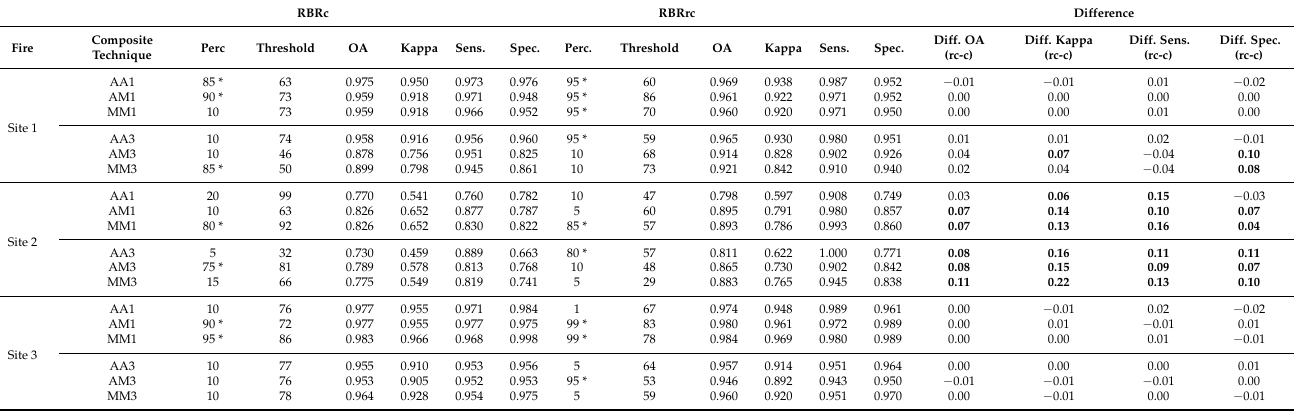
Composite technique: AA = average in pre- and post-fire composites, AM = average (pre) and minimum (post) and MM = minimum (pre and post), Perc. = best-performing RBR percentile, * percentile of the unburned sample, OA = overall accuracy, Sens. = sensitivity, Spec. = specificity, time window: 1 and 3 months, phenological correction: RBRc = RBR with constant phenological correction [73], RBRrc = RBR with relative phenological correction (proposed in this study), Diff OA (rc-c) = difference in overall accuracy between rc and c composites, Diff kappa (rc-c) = difference in kappa coefficient between rc and c composites, Diff. Sens. (rc-c): difference in sensitivity between rc and c composites, and Diff. Spec. (rc-c): difference in specificity between rc and c composites. Differences in overall accuracy, kappa coefficient, sensitivity, or specificity between rc and c composites higher than 0.05 are shown in